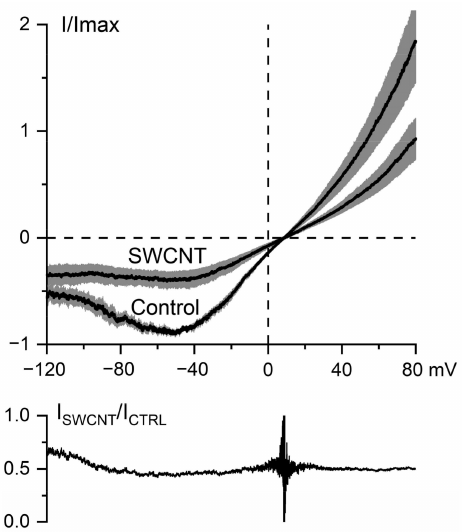
Figure 8. SWCNTs inhibit the muscarinic cation current via TRPC4 channels in a voltage-independent manner. Top, mean normalized I-V curves of GTP γ S-induced currents at maximal current activation in the control compared to those during mICAT steady-state inhibition by SWCNTs applied at 10 µ g/mL. The grey bands represent the SEM values (n = 5). Bottom, ratio of current amplitude in the presence of SWCNTs to that in control plotted vs. test